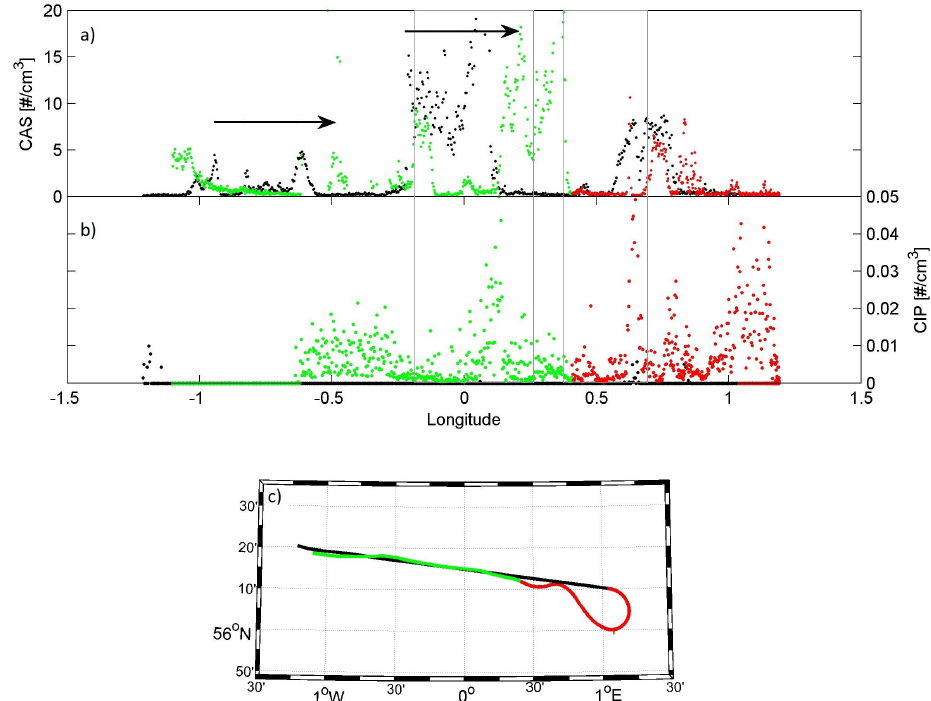
Fig. 12. (a) CAS number concentration, (b) CIP-GS number concentration and (c) the flight track for Run 3 (Black) and Run 4 (Green), mean temperature =− 61.7°C, with additional between run data also shown (red). Grey dashed boxes indicate the longitude on the return leg where we sampled the outward leg (using NAME model output). Arrows indicate the location where increases seen on the outward leg (black) were expected to be on the return leg (using the NAME model).